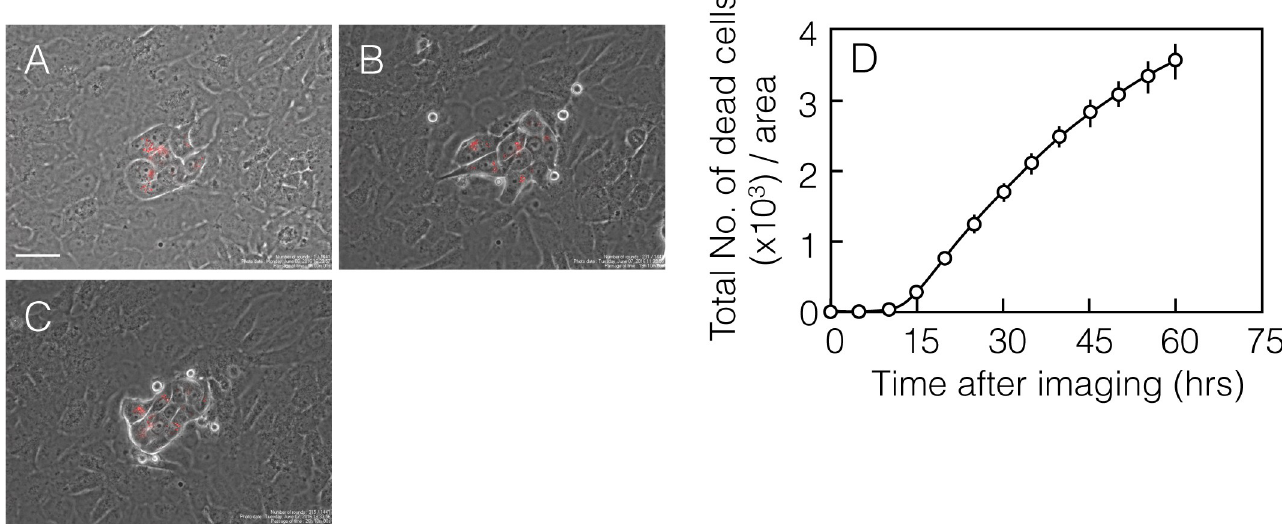
Fig 3. Time-lapse analysis demonstrates NTEC-specific cell death. ACT1 cells labeled with Qtracker 655 were incubated for 3 days before NTECs were added. Time-lapse imaging was started 48 hours after co-culture (A). Representative images of co-cultures at 18 h (B) and 24 h (C) thereafter. Spatiotemporal occurrence of dead NTECs, which appered as small round-shaped cells within 100 μ m distance from the ACT1 clusters, was recorded and summed every 5 hours. Total number of dead cells indicates the summed number of dead cells obtained every 5 hours (D). The bar indicates 40 μ m.